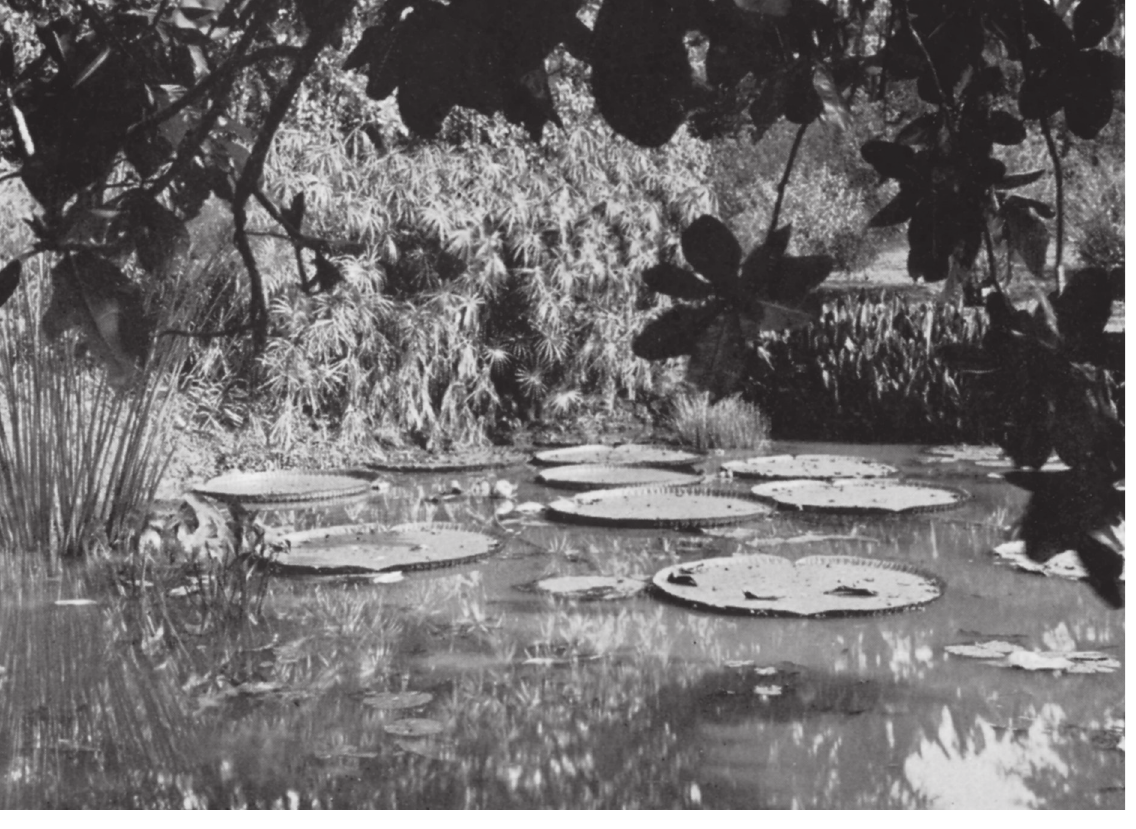
Fig. 8. Umborotula bogorensis (Weber, 1890). Possible type locality in a pond of the Bogor Botanical Garden (Java). Picture after Arndt